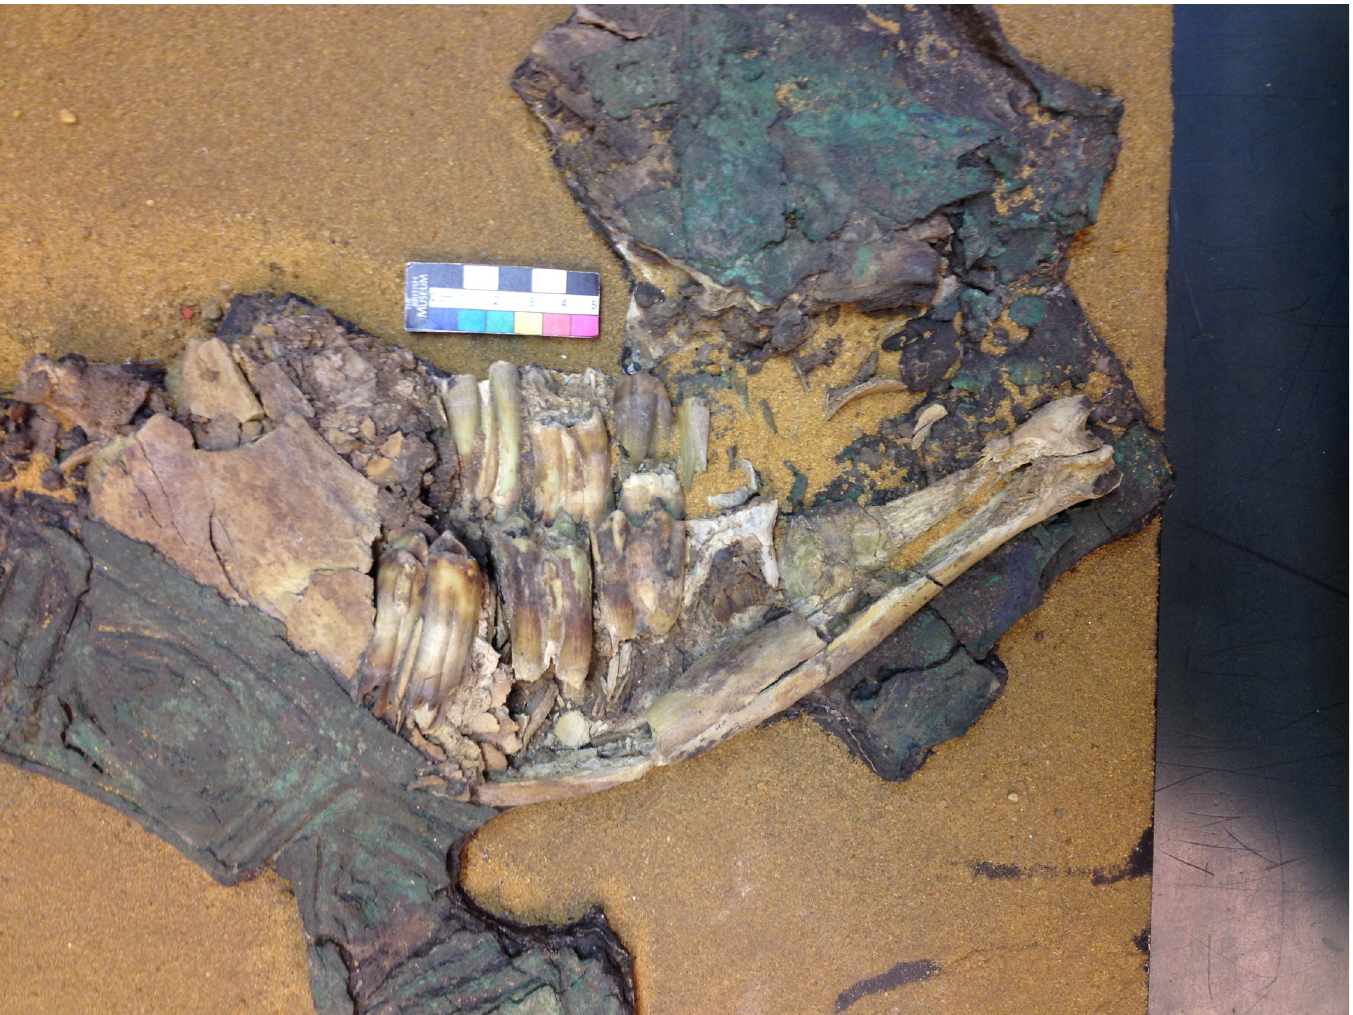
Fig 6. Cattle specimen BM3 (1928.10.10,164) PG800 Queen Pu-abi’s Grave. Note the harness attached to the animal still in place when retrieved by L. Woolley (Greenfield